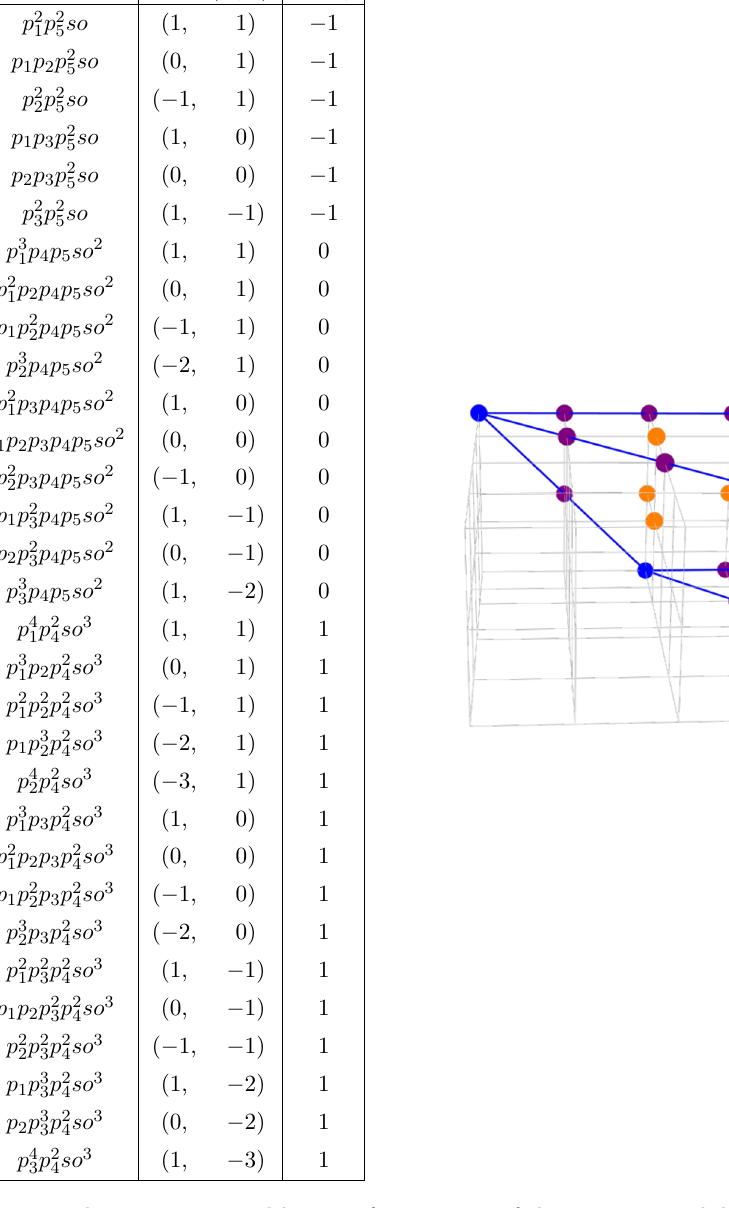
Table 13 . The generators and lattice of generators of the mesonic moduli space of Model 3 in terms of brick matchings with the corresponding flavor